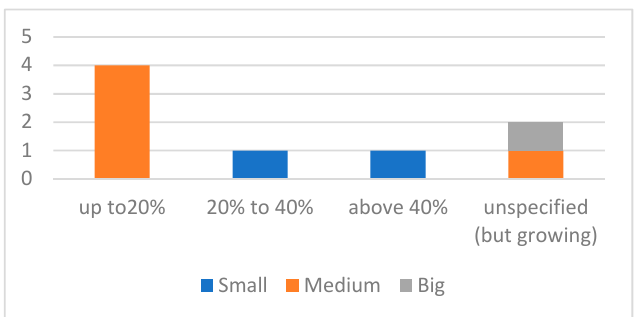
Figure 2. The response of sustainable products on the foreign market (% of total turnover).